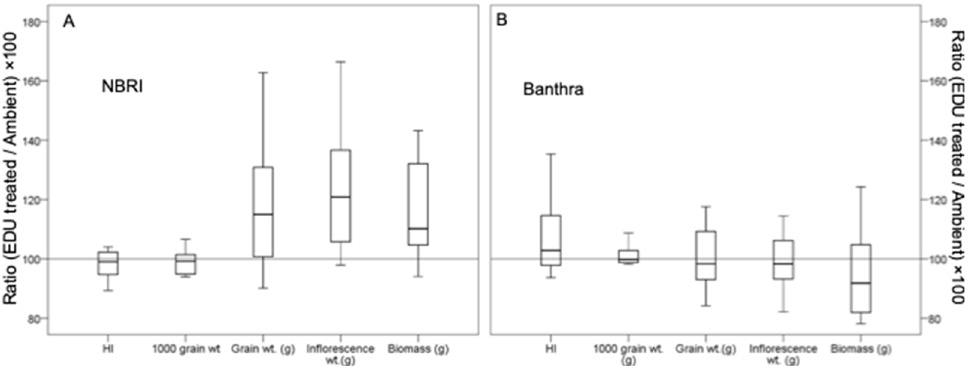
Figure 3. The effect of Ethylenediurea (EDU) treatment on various yield attributes across all the cultivars {(based on relative values, e.g., harvest index with non-EDU/harvest index with EDU treatment) × 100)}. The median of each parameter is shown as the horizontal bar in each box, and the upper and the lower sides of a box represent the first and the third quartile values of the distribution respectively. Harvest index (HI), 1000 grain weight plant − 1 (1000 grain wt.), grain weight plant − 1 (grain wt.), inflorescence weight plant − 1 (wt. of inflorescence) and biomass.